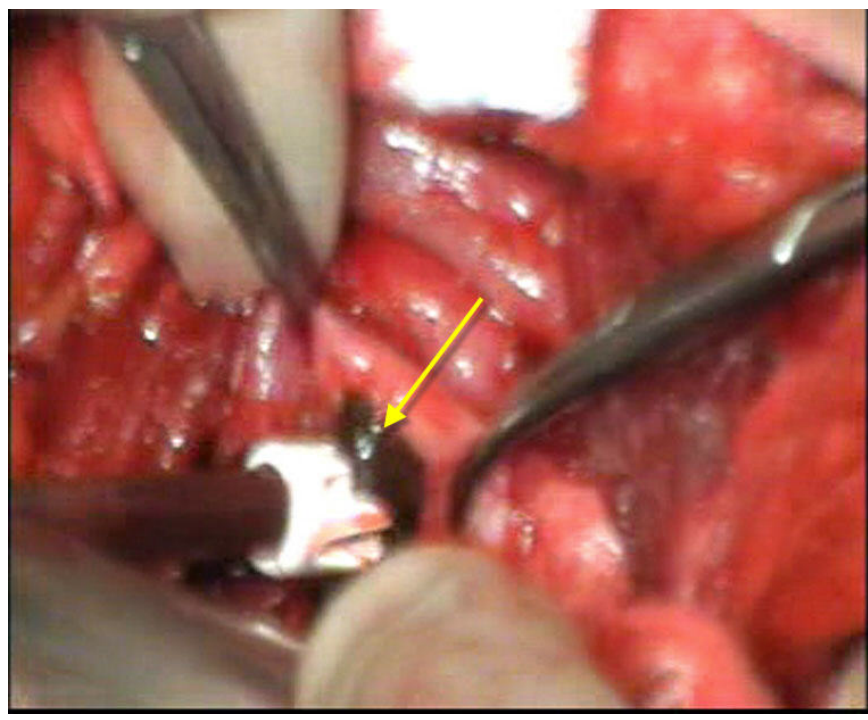
FIGURE 5. Chocolate cyst; thick brown fluid content.